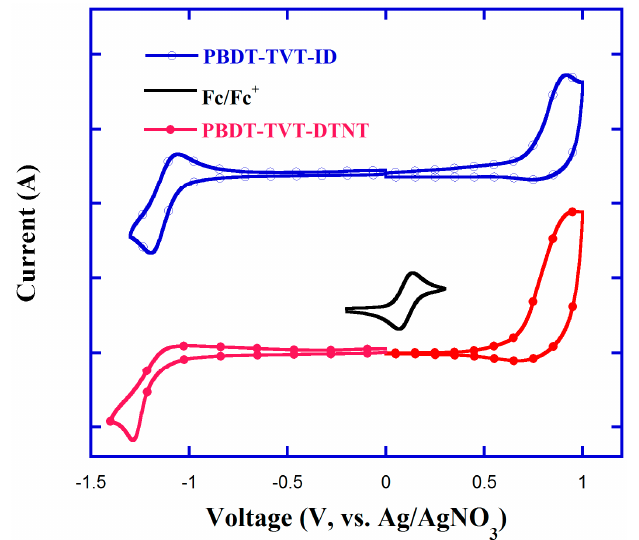
Figure 3. CV curves of PBDT-TVT-ID and PBDT-TVT-DTNT.